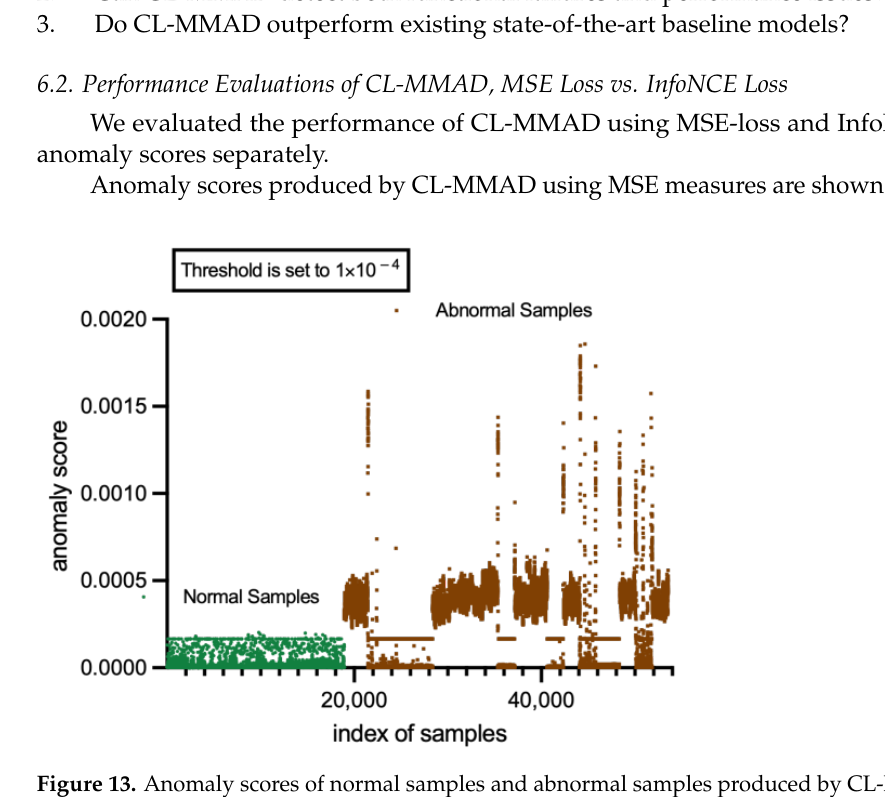
15 of 21 Figure 12. Train and test loss using InfoNCE loss, group 2: ( a ) the train loss; ( b ) the test loss; the model is overfitting after nearly 4 × 10 4 batch iterations. The lowest values of the test loss are nearly